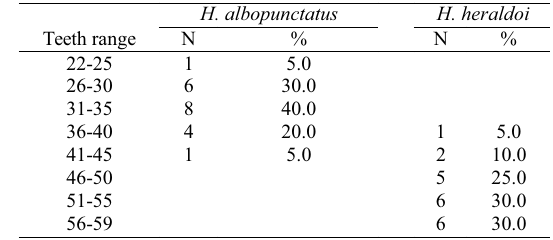
Table 2. Frequency of premaxillary teeth in Hypostomus albopunctatus and H. heraldoi